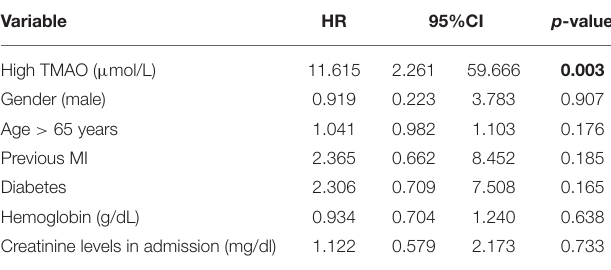
TABLE 5 | Univariate Cox regression for prediction of long-term cardiovascular mortality.